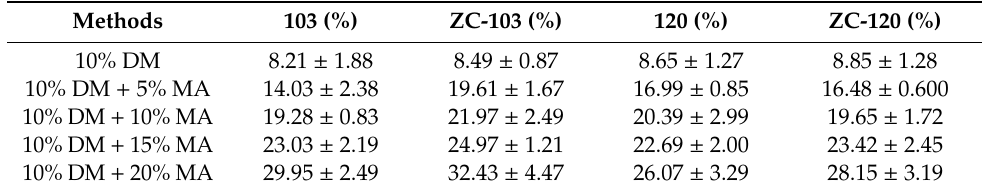
Table 1. WPG of wood for di ff erent groups after leaching cycles. Methods